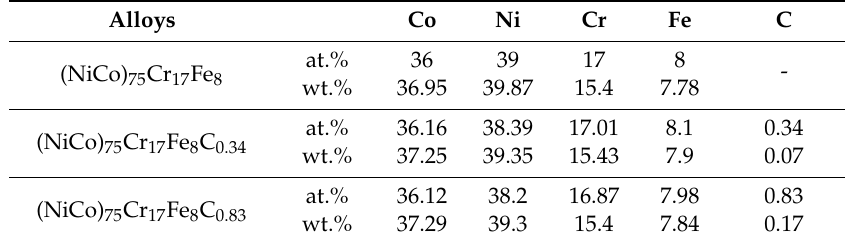
Table 1. Chemical composition of the (Ni,Co) 75 Cr 17 Fe 8 C x alloys in atomic percentage (at.%) and weight percentage